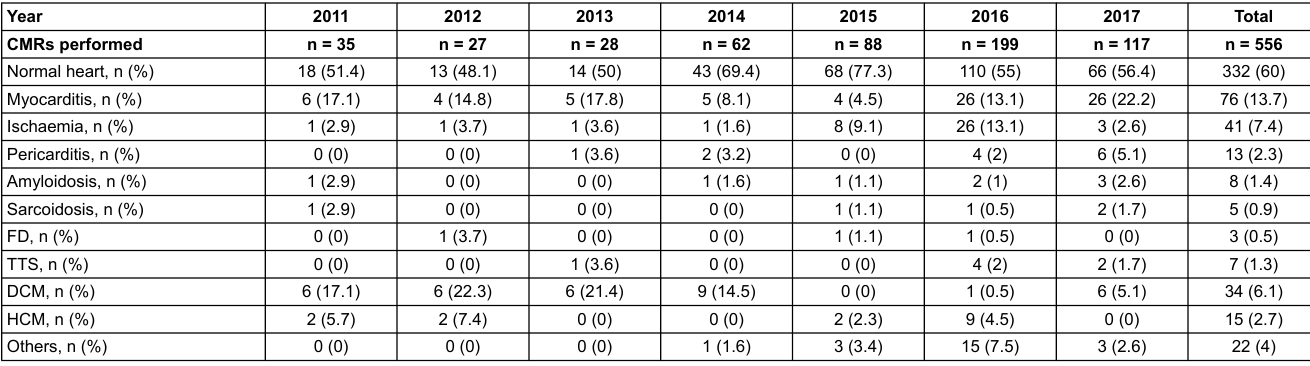
Table 2: Diagnoses based on cardiac magnetic resonance imaging in the years